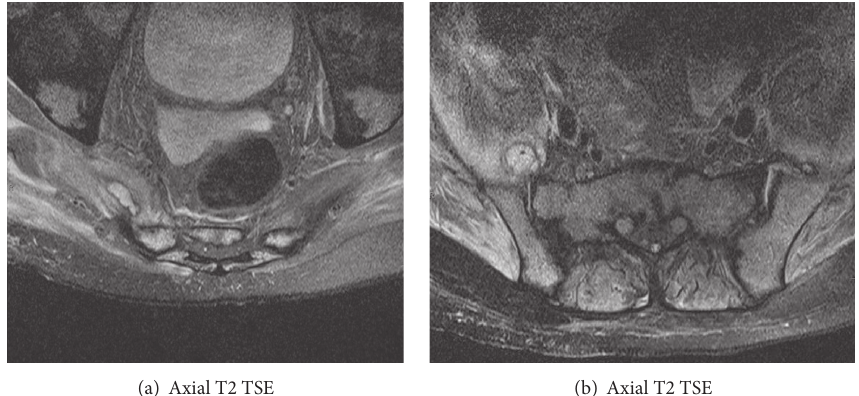
Figure 2: Axial T2 weighted images following a lumbosacral plexus protocol show right psoas fluid collections (a) and a fluid collection in the right iliopsoas muscle anterior to the sacroiliac joint (b). The smaller contralateral collection anterior to the left sacroiliac joint is not shown. Note diffuse muscle edema asymmetrically affecting the gluteal and iliacus musculature.